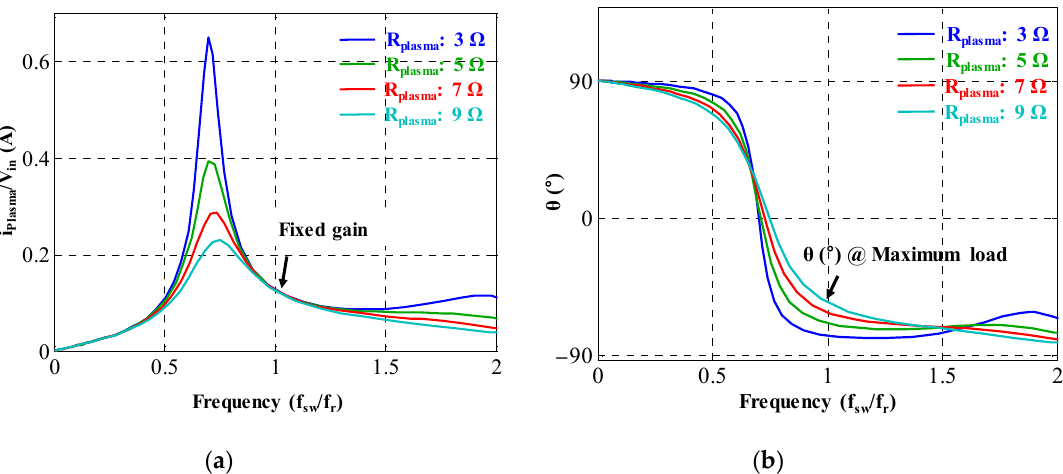
Figure 7. Characteristics of the LCCL network for designing a PCS: ( a ) output current characteristics of the LCCL network and ( b ) phase angle characteristics of the LCCL network.